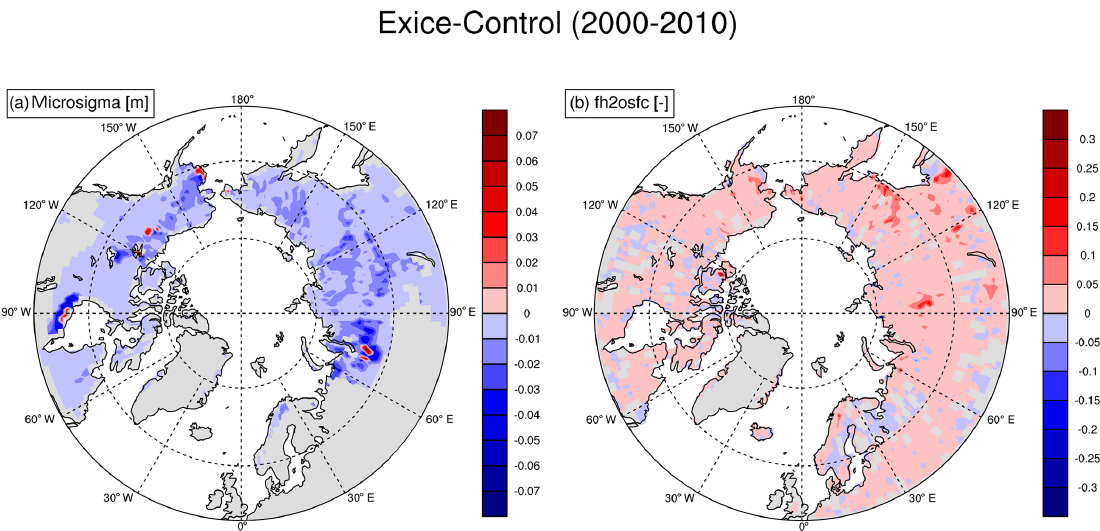
Figure 2. Effects of coupled subsidence-microsigma parameterization on “ σ micro ” and “ f h2osfc ” from > 50 ◦ N difference maps of the Exice–Control experiments for the period 2000–2010.